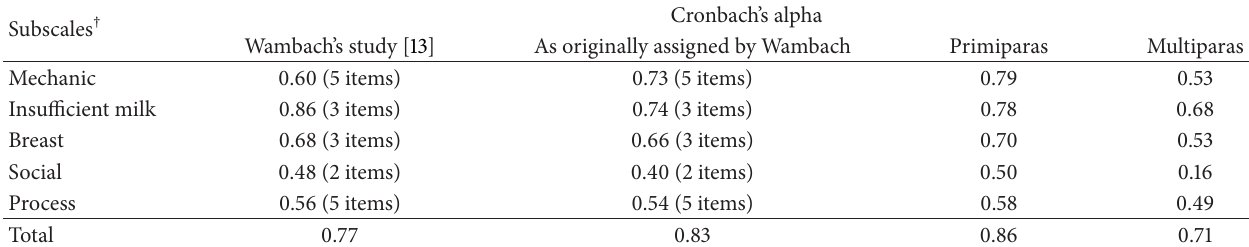
Table 3: Cronbach’s alpha of the BES subscales as originally assigned by Wambach.